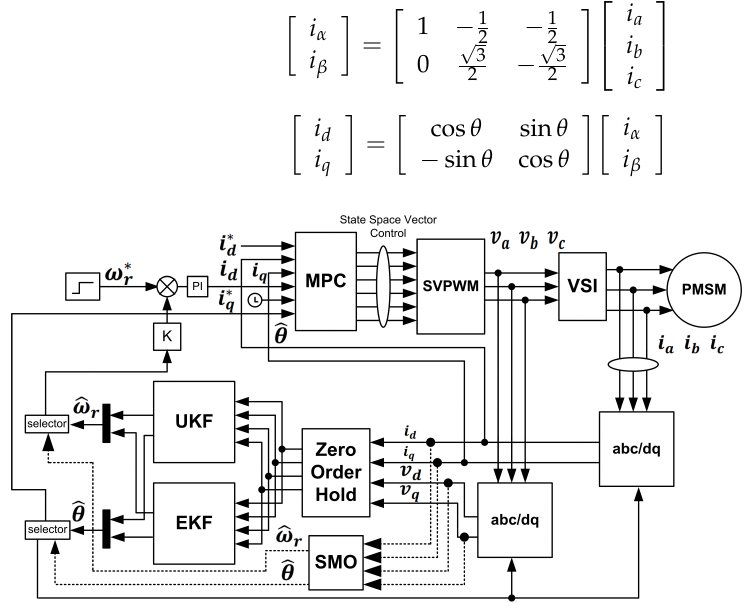
Figure 1. Schematic diagram of the proposed